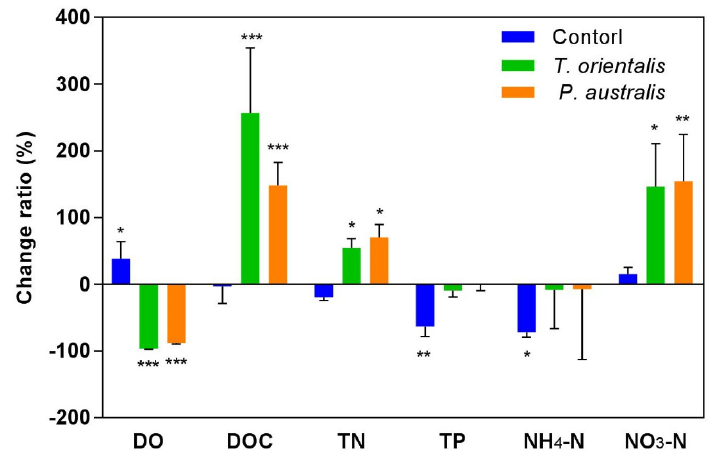
Figure 4. Change ratios of DO, DOC, TN, TP, NH 4 -N, and NO 3 -N in the water columns before and after the experiment. *** Significance at p < 0.001; ** significance at p < 0.01; and * significance at p < 0.05 (paired t test).